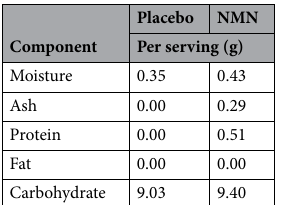
Table 2. Nutrition content of the test foods.